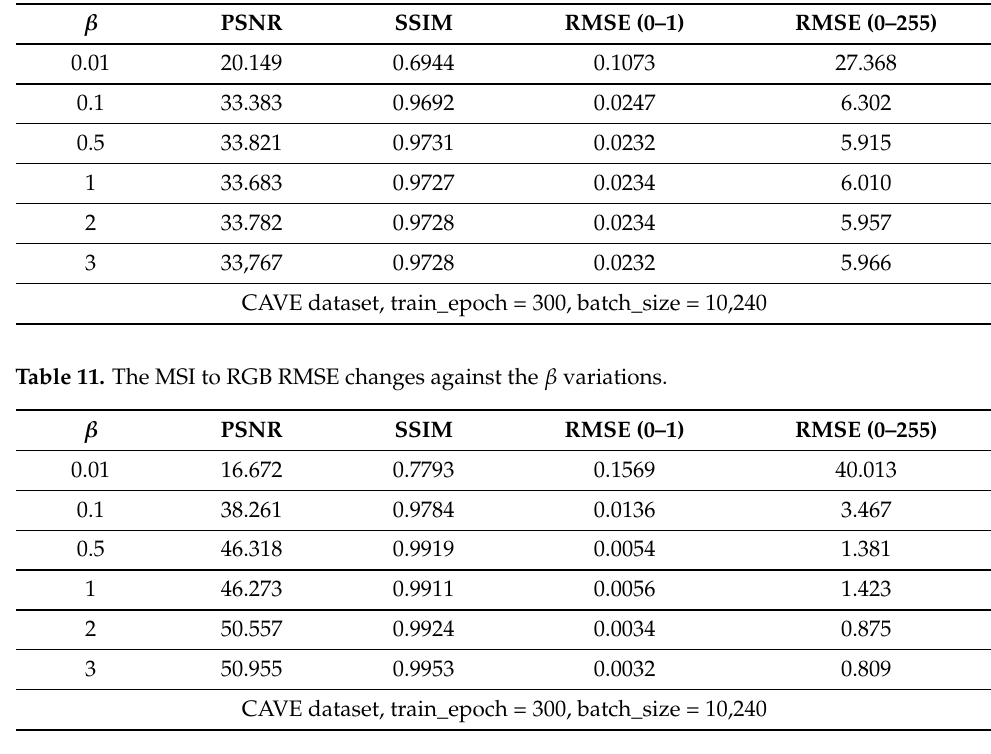
Table 10. The RGB to MSI RMSE changes against the β variations.